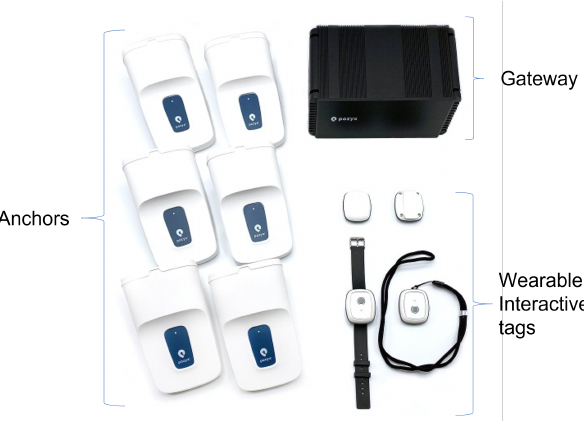
Figure 1. Pozyx Hardware devices.